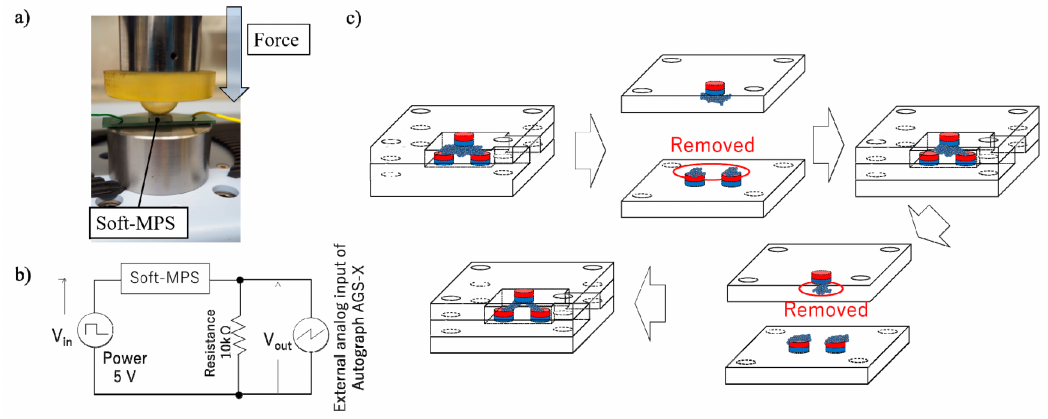
Figure 4. The experimental setup: ( a ) loading of the soft-MPS; ( b ) circuit to detect the voltage change. The voltage was measured at the resistor (10 k Ω ); ( c ) removing excess iron